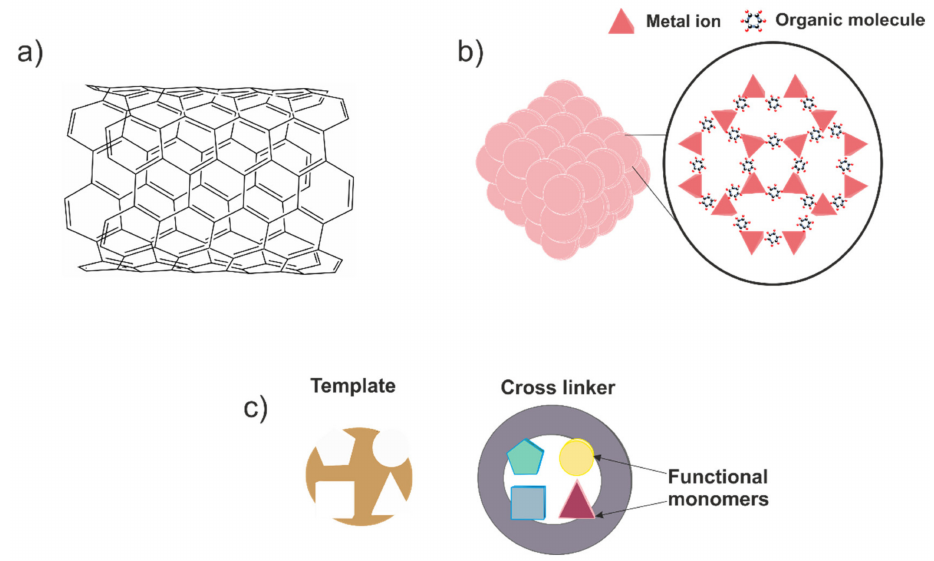
Figure 4. Main alternate approaches to enzyme-based lactate sensors: ( a ) nanomaterials, ( b ) metal– organic frameworks (MOFs) and ( c ) molecularly imprinted polymers